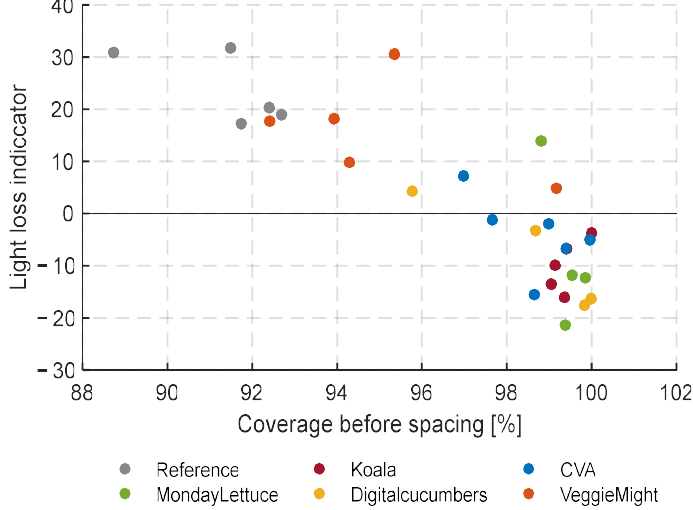
Figure 19. Light loss calculation for all compartments for the spacing instances of the second experiment. Negative values indicate a (too) late spacing and large positive values a too-early spacing.